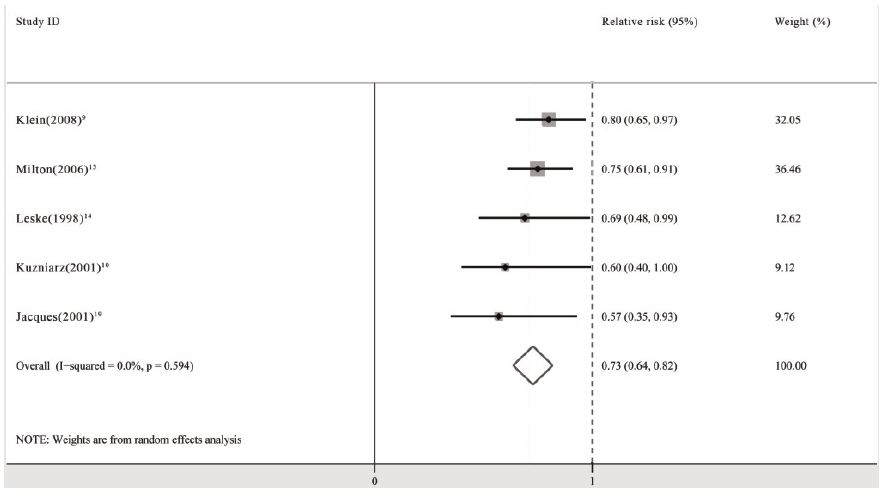
Figure 1. Pooled relative risk (95% CI) of nuclear cataracts comparing the longest duration of multivitamin/mineral supplementation with no supplementation.